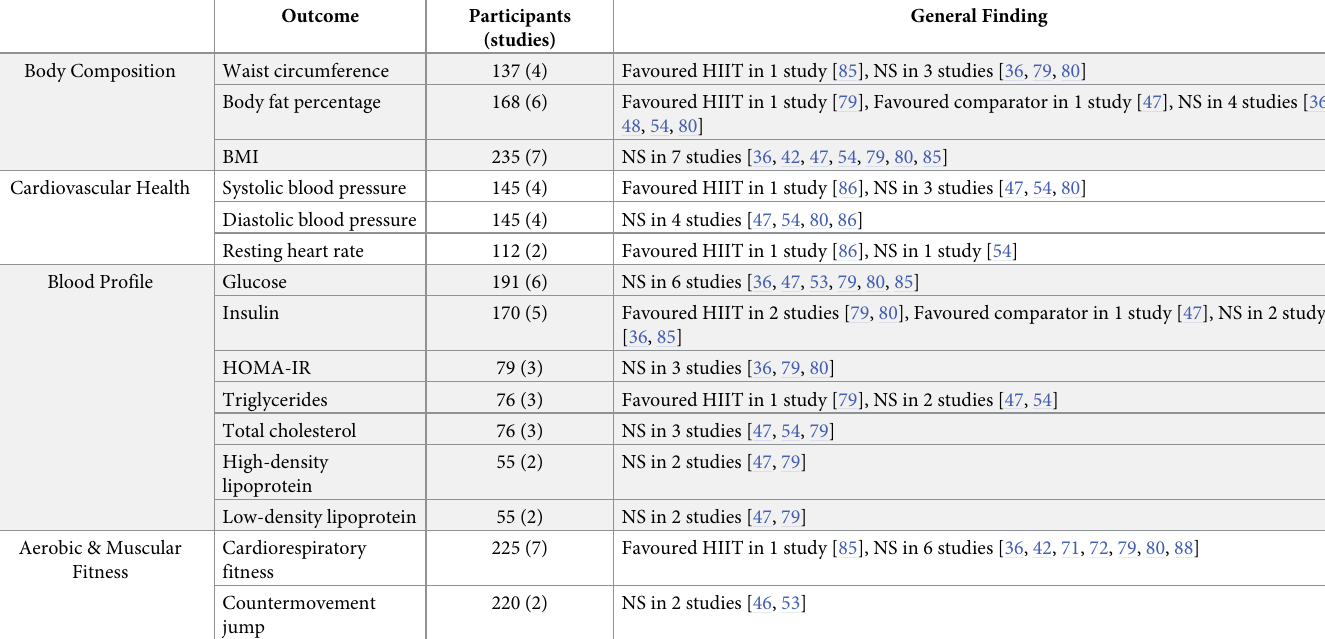
Table 5. Summary of outcomes between HIIT and comparative exercise groups for all outcomes reported in � 2